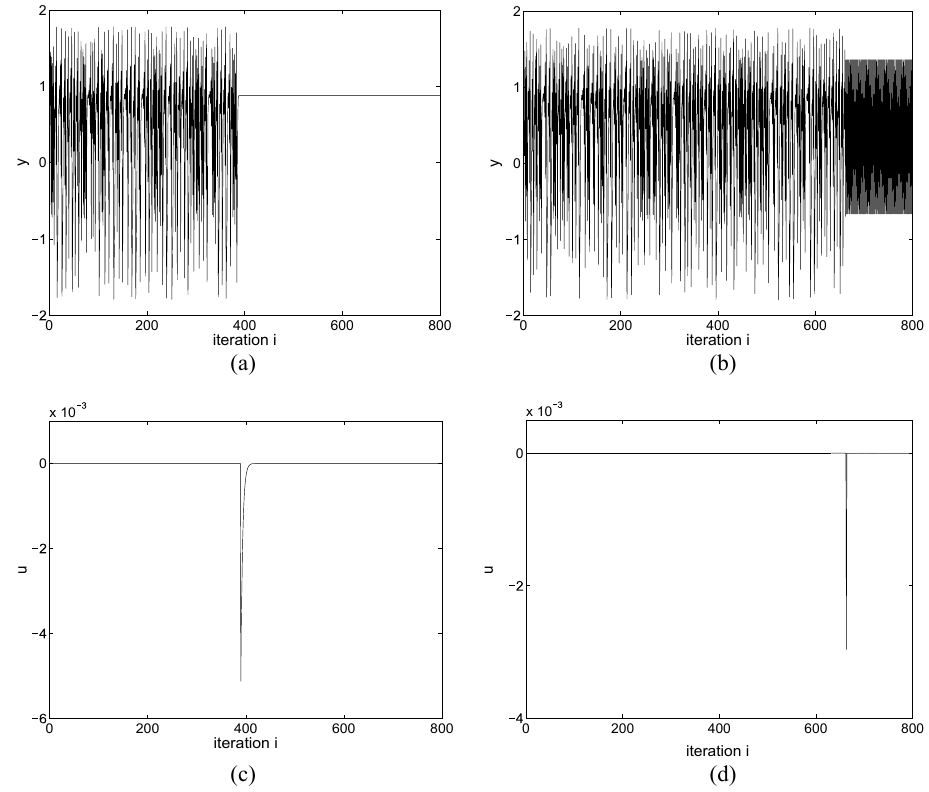
Fig. 8. The controlled T-S Fuzzy system. (a) and (c) T-S Fuzzy system stabilized on the fi xed point. (b) and (d) T-S Fuzzy system stabilized on the periodic orbit. It exhibits a chaotic regime for a = 1 . 4 and b = 0 . 3